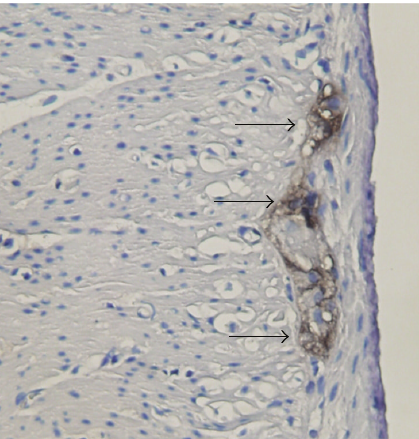
Figure 4: EGC in the rat myenteric plexus of the stomach (protein gene product S100B immunohistochemistry, × 40); dark brown region (black arrows) is EGC of myenteric nerve plexus. EGC are gathered together and form a cell network. Enteric neurons are packed around tightly by